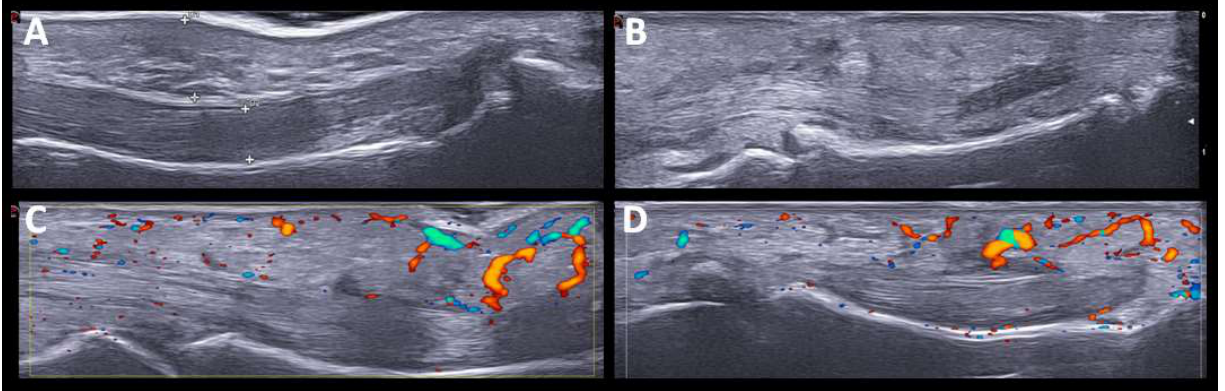
Figure 3. US findings in PsA-like pattern. Hand dactylitis. The US findings include soft tissue thickening, subcutaneous edema and flexor tenosynovitis ( A , B ) with Power Doppler signal ( C , D ).